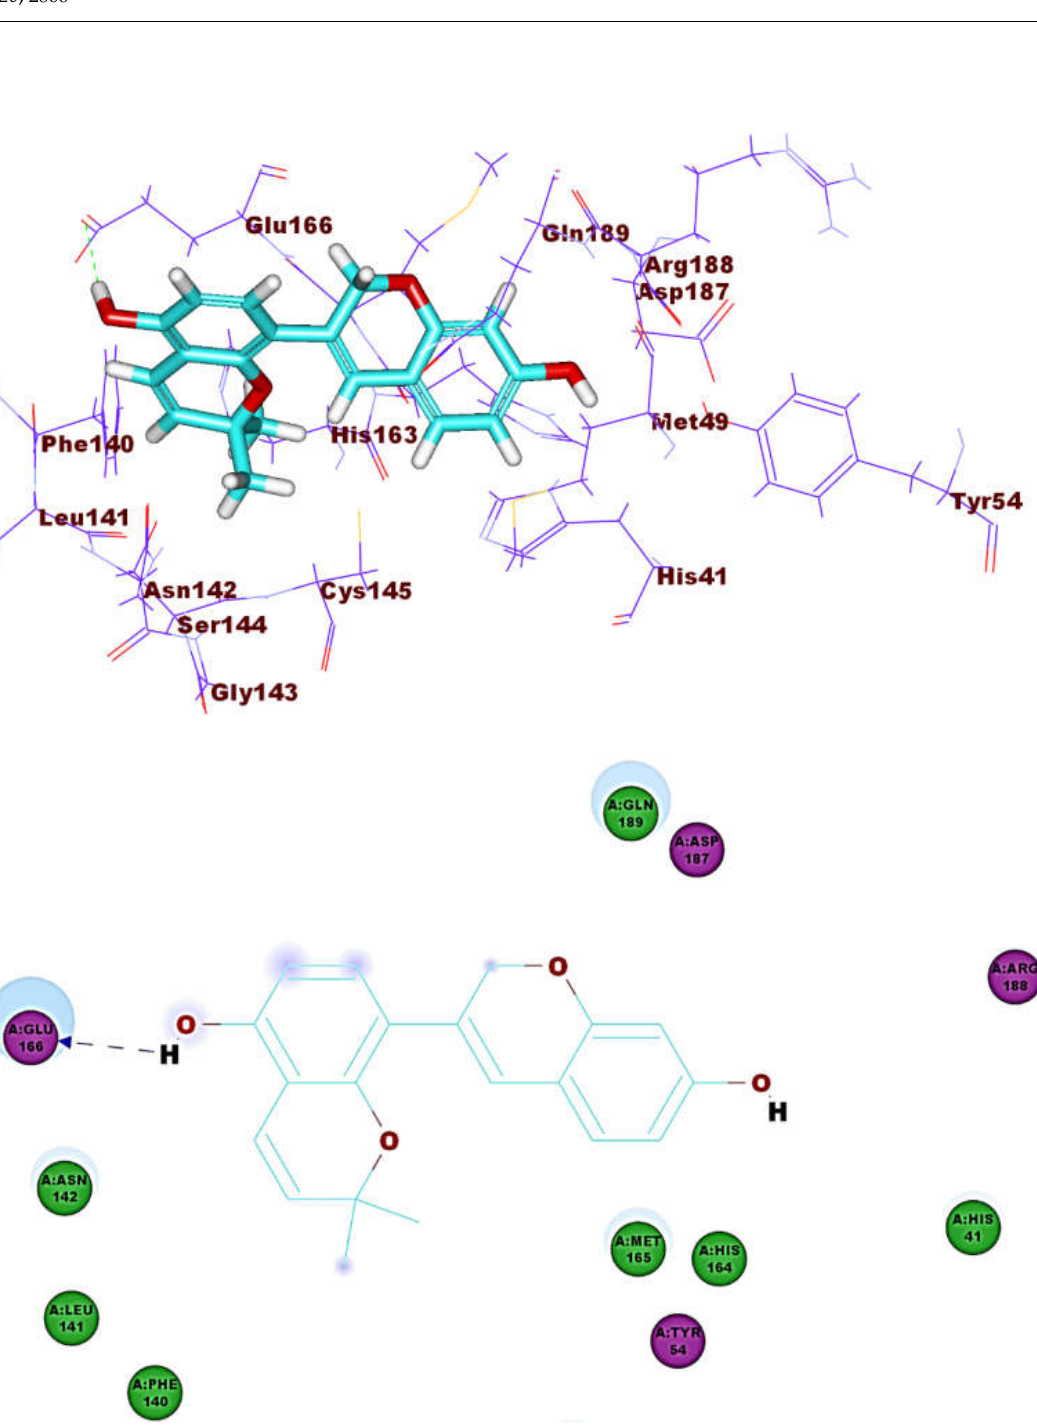
Figure 10. Compound 6 docked into M pro , forming one H. bond with Glu166.